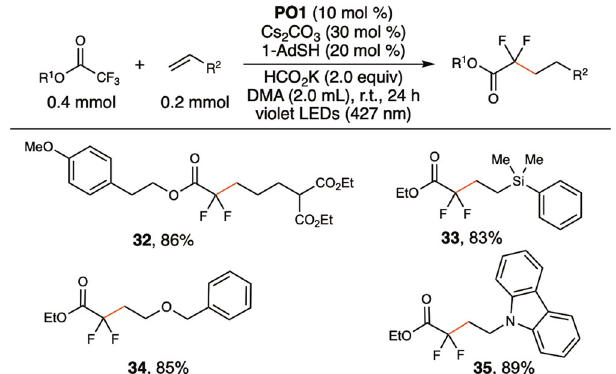
Fig. 4 Examples of de fl uoroalkylation of tri fl uoroacetates. Yields of isolated products.